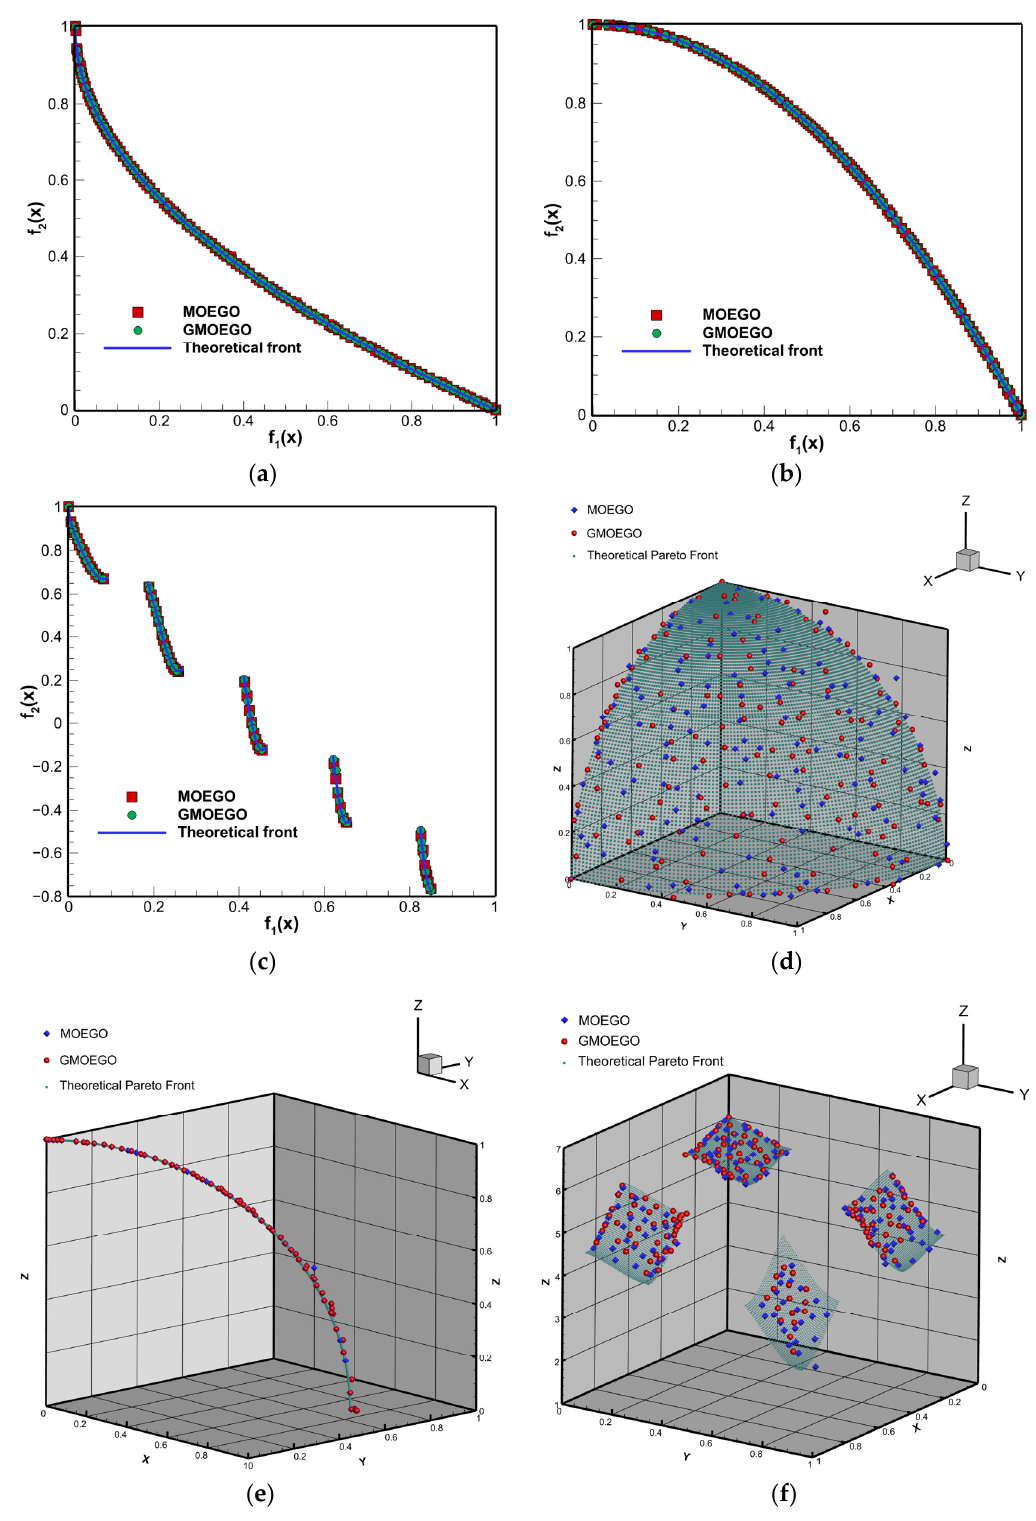
Figure 7. Pareto front comparisons: ( a ) ZTD1; ( b ) ZTD2; ( c ) ZTD3; ( d ) DTLZ2; ( e ) DTLZ5; ( f ) DTLZ7.